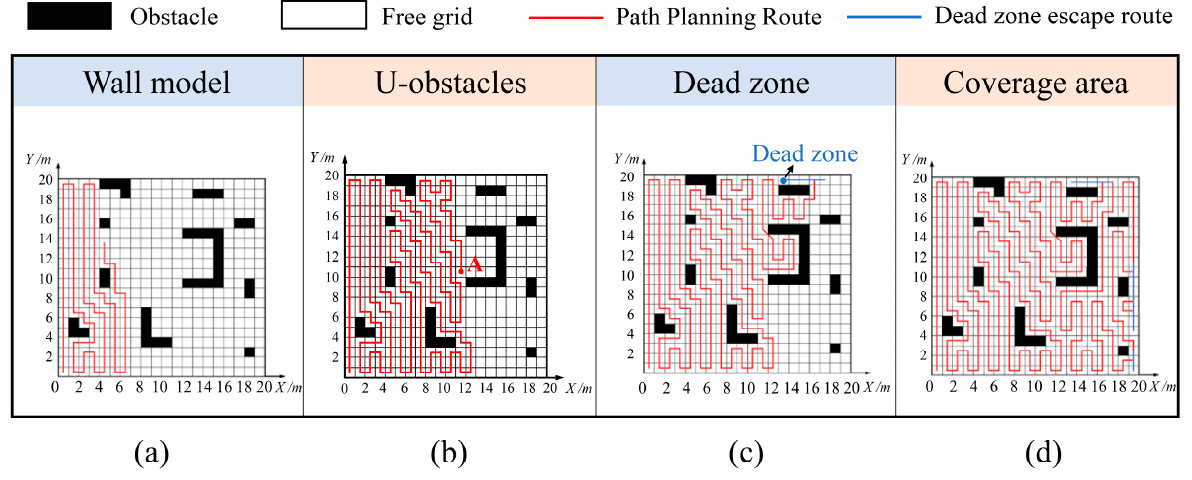
Figure 12. Full-coverage path planning: ( a ) wall model; ( b ) U obstacles; ( c ) dead zone; ( d ) coverage area.